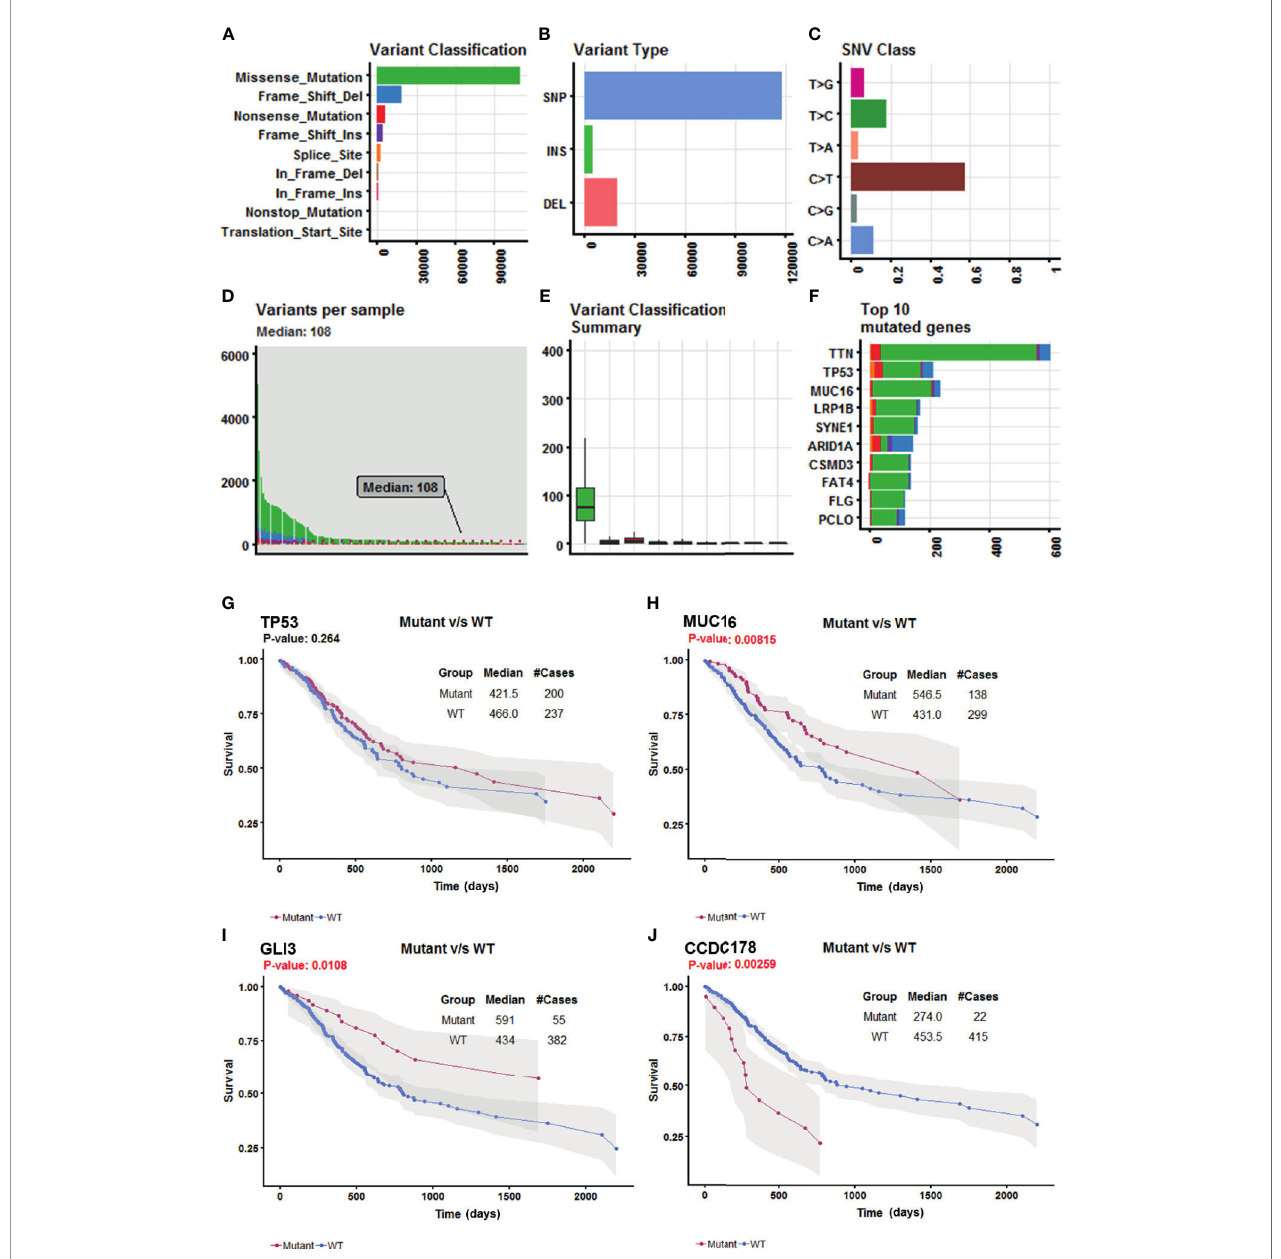
FIGURE 1 | Selection of survival-related mutated genes in The Cancer Genome Atlas (TCGA) Stomach Adenocarcinoma (STAD) cohort. (A – C) Characteristics of the variations in TCGA STAD cohort. Histogram summarizing the variant types of all cases with substitutions, insertions, deletions, and SNP (single nucleotide polymorphism). (D) Stacked bar showing the cumulative frequency of variation for individual cases. (E) Boxplot summarizing the number of cases for each type of variant. (F) Stacked bar showing top 10 mutated genes. (G – J) Kaplan – Meier survival analyses strati fi ed by TP53, MUC16, GLI3, and coiled-coil domain-containing protein 178 (CCDC178) mutation status, respectively. This analysis was implemented in the R package